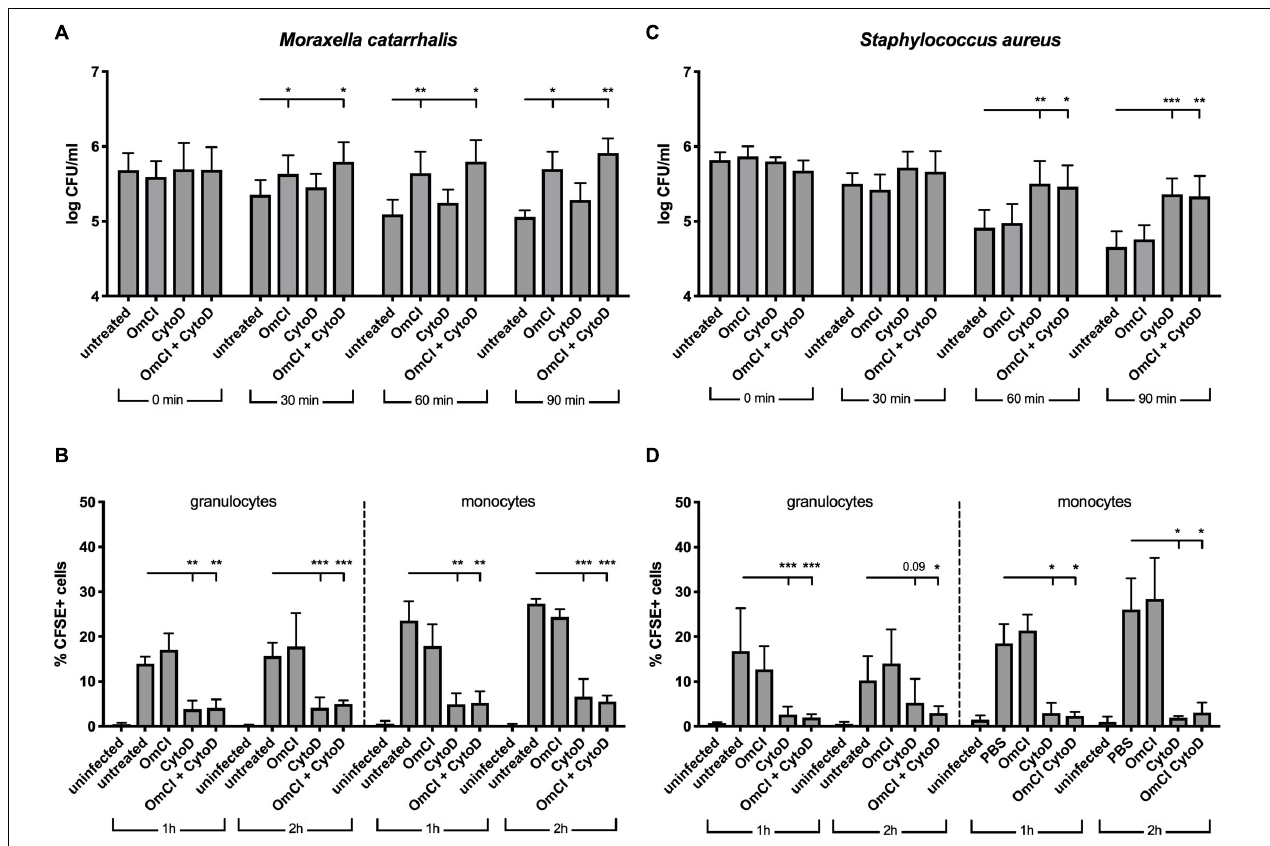
FIGURE 3 | In a whole blood model, M. catarrhalis is killed through MAC-mediated killing. CFSE-labeled bacteria were added to whole blood previously incubated with 1 µ M OmCI, 10 µ M cytochalasin D or both. (A,B) M. catarrhalis clinical isolate #473 was picked as more serum resistant than most clinical isolates and the reference strain RH4 (C,D) Staphylococcus aureus JE2 was used as an example of MAC-resistant bacteria (A,C) Survival of bacteria overtime was assessed by collecting a sample at t = 0, 30, 60, and 90 min post-infection, and plating bacteria on agar plates. The number of bacteria is represented as log of CFU/ml. (B,D) Phagocytosis was assessed by detection of CFSE+ cells among granulocytes and monocytes from whole blood. At 1 and 2 h post-infection, a sample was collected, red blood cells were lysed, cells were fixed and stained with anti-CD14, and cells were analyzed using flow cytometry. The percentage of CFSE+ cells was measured in granulocytes and monocytes (gated using Side Scatter and CD14 staining). Mean ( ± SD) from four (A) or three (B–D) independent experiments are shown. Statistical significance of differences was calculated using two-way ANOVA with Dunnett’s post-test; * p < 0.05; ** p < 0.01; and *** p <